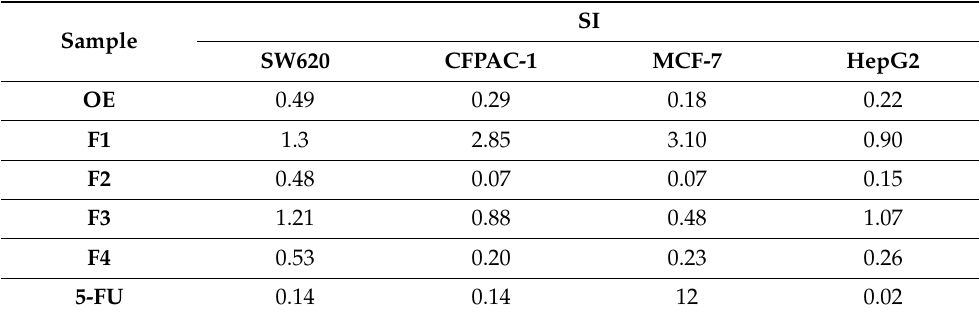
Table 7. Selectivity index (SI) of OE and F1 – F4 tested against four human cancer cell lines: SW620, CFPAC-1, MCF-7 and